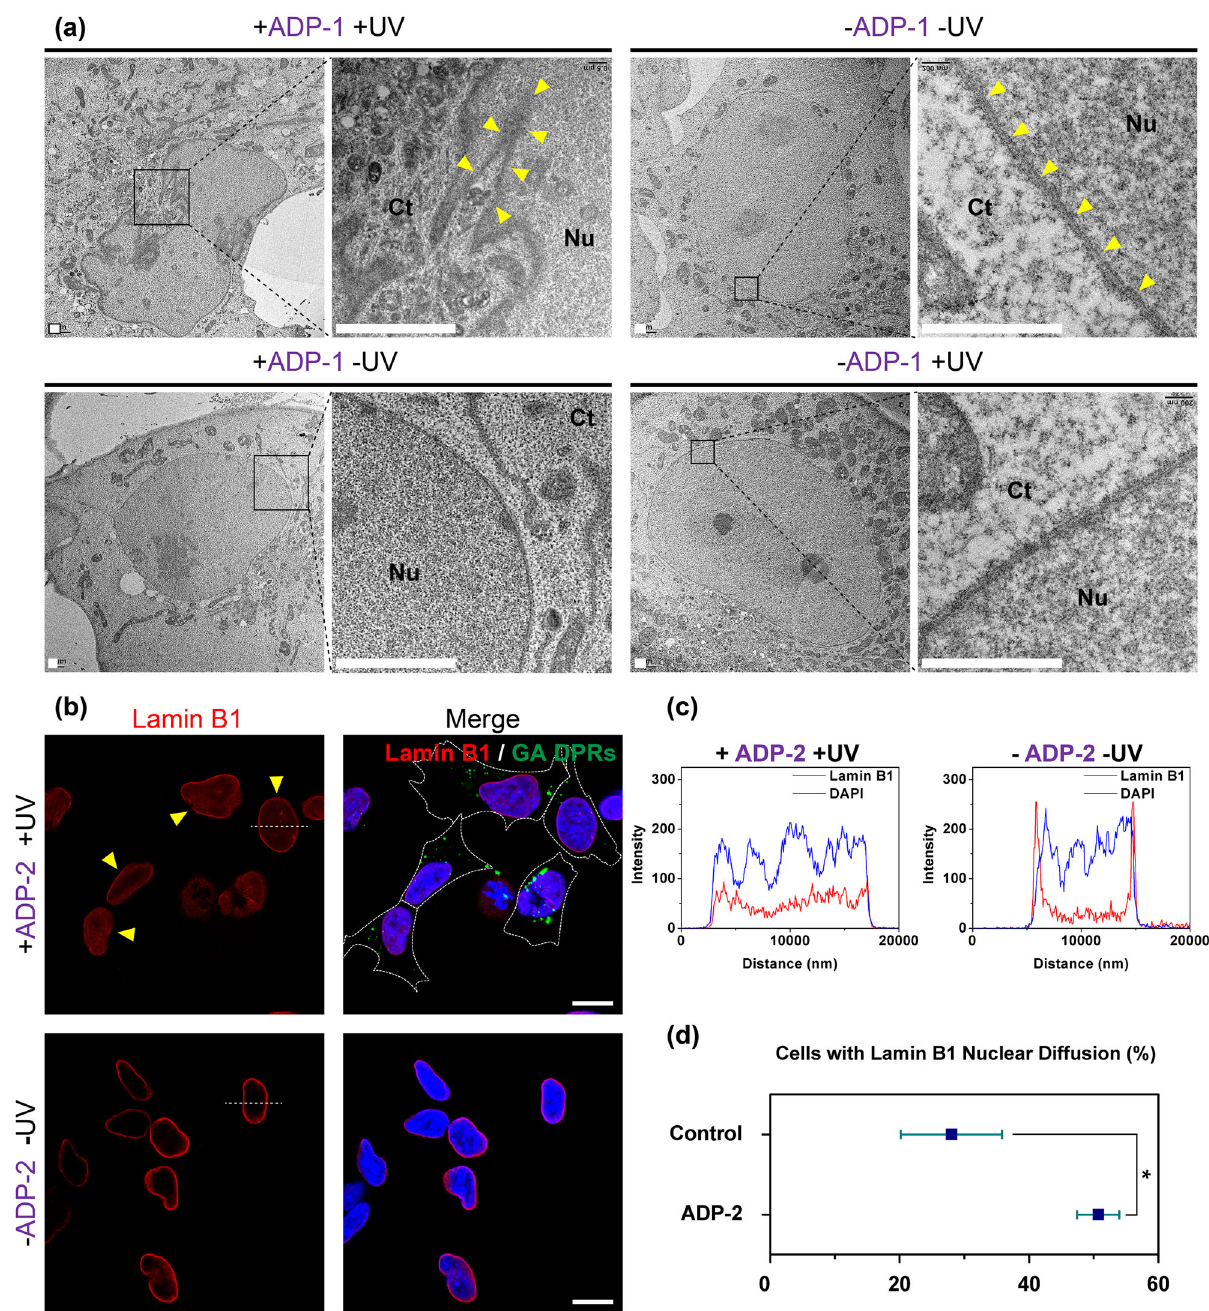
Fig. 4 GA DPRs disrupt the nuclear membrane and lamina. a Transmission electron microscope images of in Cos-7 cells with ADP-1 treatment and photoinitiation, ADP-1 treatment only, photoinitiation only, and not treatment. Cos-7 cells were treated with ADP-1 (1 µ M), photoinitiated, and then incubated for 24 h. Yellow arrows indicate the nuclear membrane. Black squares indicate the view of zoom-in images. Scale bars indicate 1 µ m. b Immuno fl uorescence images of lamin B1 (red) in GA DPRs (green)-rich SH-SY5Y. Cells were treated with ADP-2 (1 µ M), photoinitiated, and then incubated for 24 h. Yellow arrows indicate the lamin B1 nuclear diffusion. White dash line in the lamin B1 channel indicates the region for fl uorescence intensity pro fi ling. Scale bars indicate 10 µ m. c Fluorescence intensity pro fi le of the cells in Fig. 4B. Red curve indicates lamin B1 channel and the blue curve indicates DAPI channel. d Quanti fi cation analysis demonstrated the majority of cells with lamin B1 nuclear diffusion after ADP-2 treatment and photoinitiation ( + ADP-2 + UV). Three biological replicates were carried out ( r = 3). More than 53 cells were counted and analyzed in each group ( n ≥ 53). Mean and standard deviation for group control = 28.0 ± 7.8; ADP-2 = 50.7 ± 3.3. * indicates statistical signi fi cance where p value < 0.05 ( p value = 0.019, analyzed by two-sided Welch ’ s T test, degree of freedom = 3, t value =